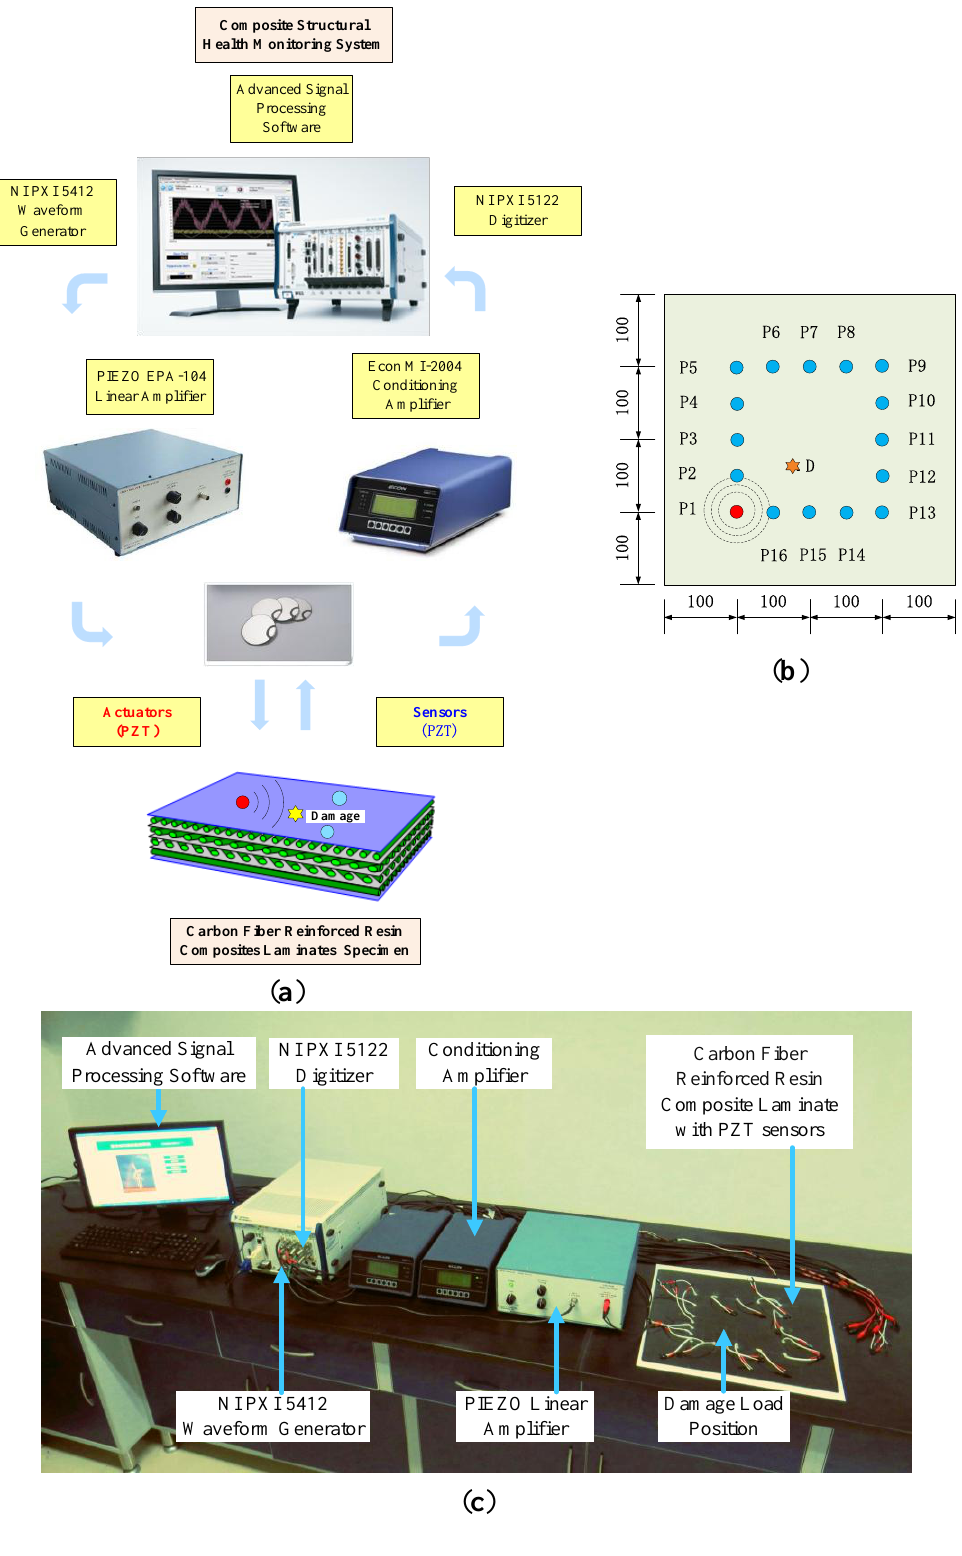
Figure 8. Schematic of damage detection using the proposed monitoring system with active sensor network. ( a ) Block diagram of the experimental system; ( b ) 16 PZT actuator and sensor layout on CFRRCL specimen (unit: mm); ( c ) Overall view of experiment